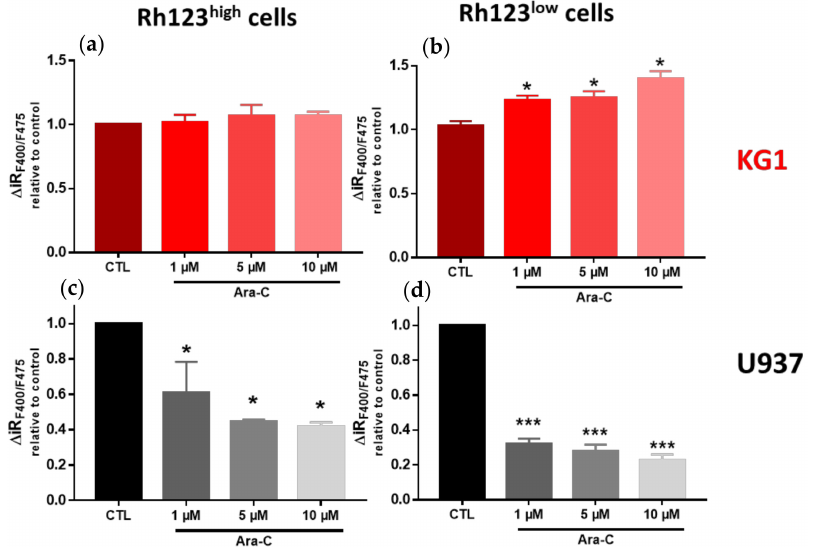
Figure 8. Effect of Ara-C on SOCE in Rh123 high and Rh123 low KG1 and U937 cell subpopulations. Cells were treated for 24 h with Ara-C at the indicated concentrations. For each condition, three independent experiments were performed. Flow cytometric analysis of the impact of Ara-C on SOC channel activity in the Rh123 high ( a , c ) and Rh123 low ( b , d ) KG1 and U937 cell subpopulations. The delta of the F400/F475 ratio reflects the capacitative Ca 2+ entry in the Rh123 high and Rh123 low cell subpopulations. * p ≤ 0.05; *** p < 0.001.